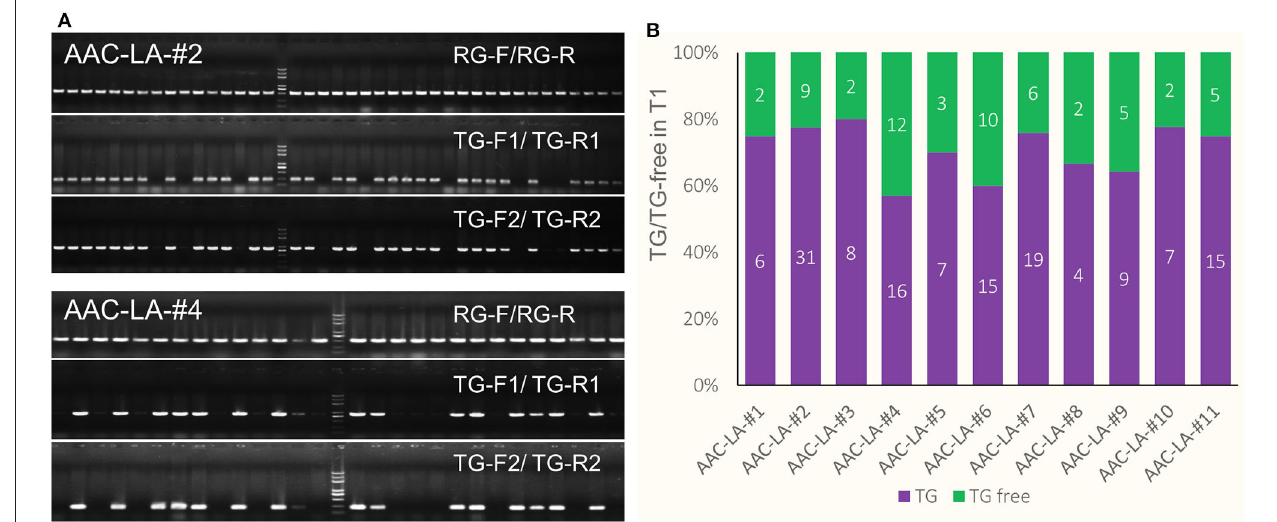
FIGURE 3 | Isolation of transgene-free T1 plants by anthocyanin-marker assisted strategy. (A) The transgene-free plants from the progeny of the T0 plants that had purple color were identified by PCR and visual screen. AAC-LA–#2 and AAC-LA-#4 represent two AAC-LA T0 plants with purple color, respectively. (B) The segregation of the transgene (TG) and transgene-free (TG-free) plants from 11 AAC-LA T0 lines. The numbers on purple and green columns represent the numbers of purple and normal colored plants at T1 generation. The results were consistent with the results identified by PCR. “RG-F/RG-R” refers to primer pair used for checking the quality of rice genome DNA. “TG-F1/TG-R1,” and “TG-F2/TG-R2” represent two primer pairs used for detection the presence of T-DNA, respectively. The primers information was described in Supplementary Table 3